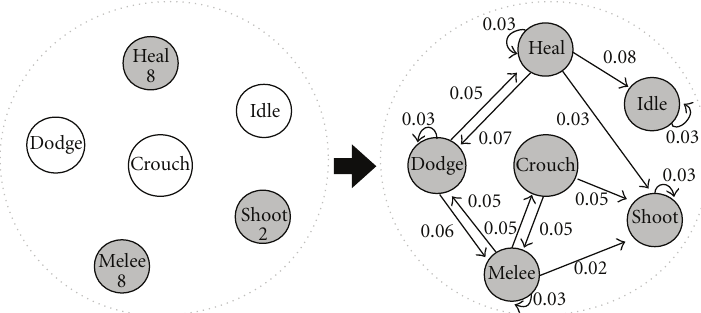
Figure 15: An example, TAP based on temporal links. In the new TAP model (right), a weighted topology depicting the preferential sequence of actions is added to the previous personality model